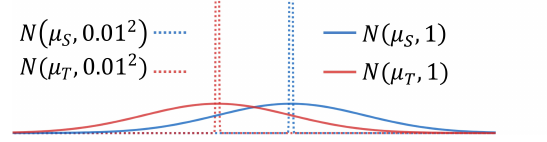
Figure 2. The effect of randomness on RD.